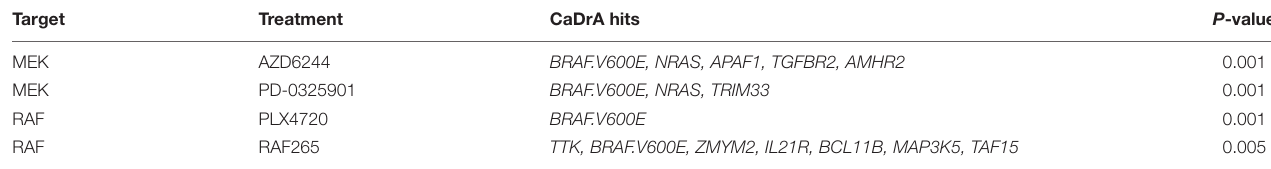
TABLE 2 | Summary of mutation subsets identified by CaDrA as associated with elevated Mek and Raf inhibition in cancer cell lines. Target